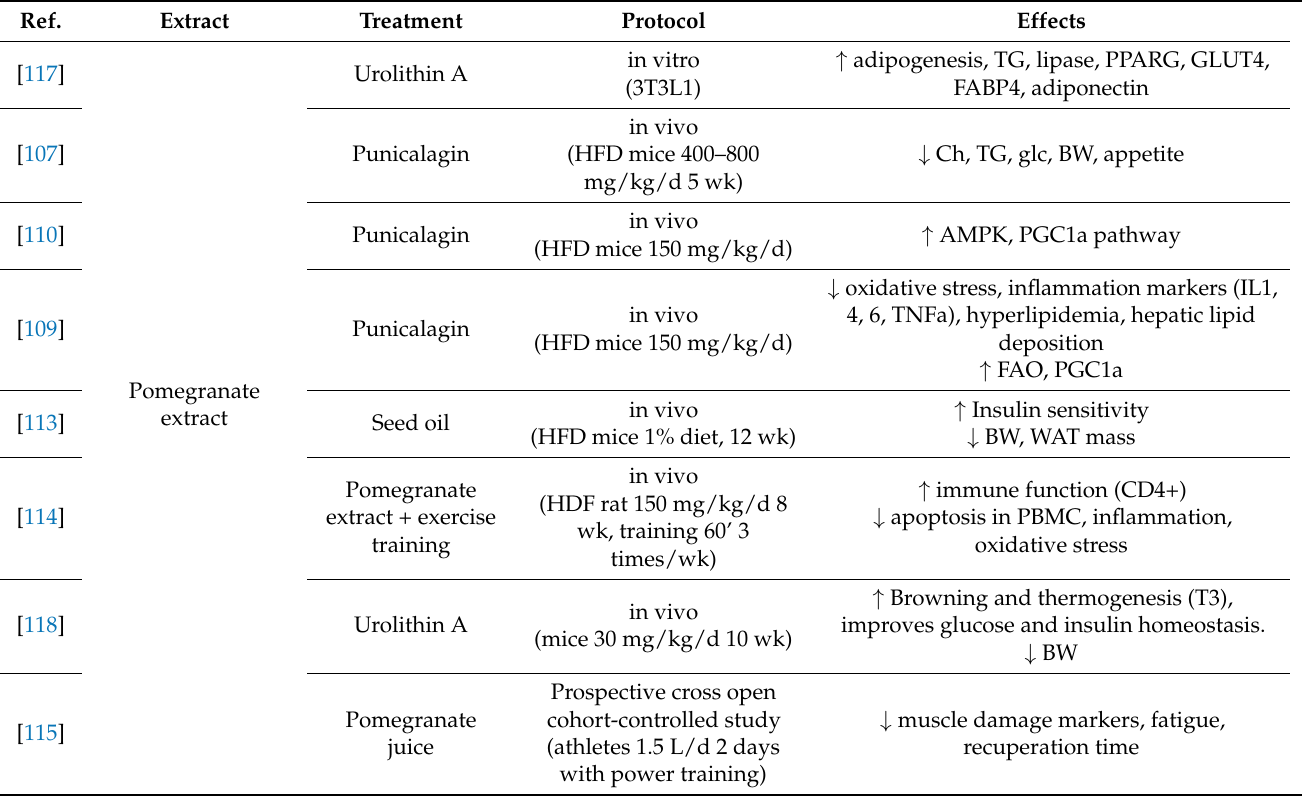
Table 1. Antiobesity and thermogenic effects of pomegranate, silymarin, ginkgo and resveratrol extracts and their potential molecular mechanism of action.